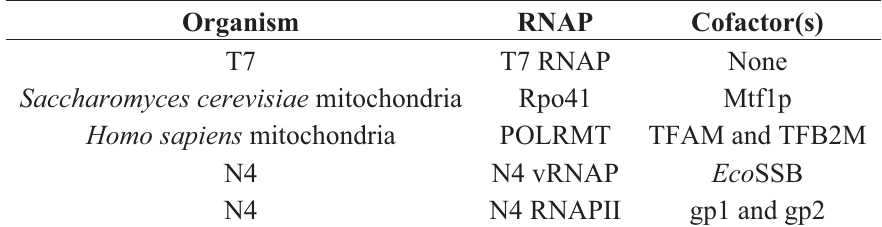
Table 1. T7-like RNAPs and their required